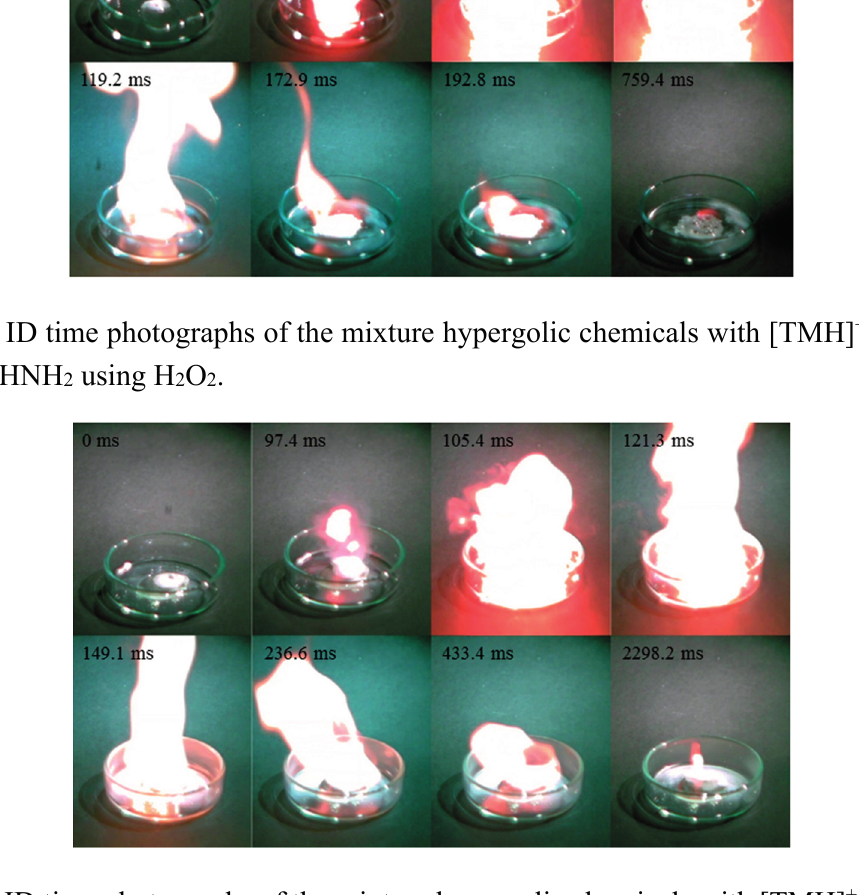
Figure 5. ID time photographs of the mixture hypergolic chemicals with [TMH] + [CN] − and HOCH 2 CH 2 NHNH 2 using H 2 O 2